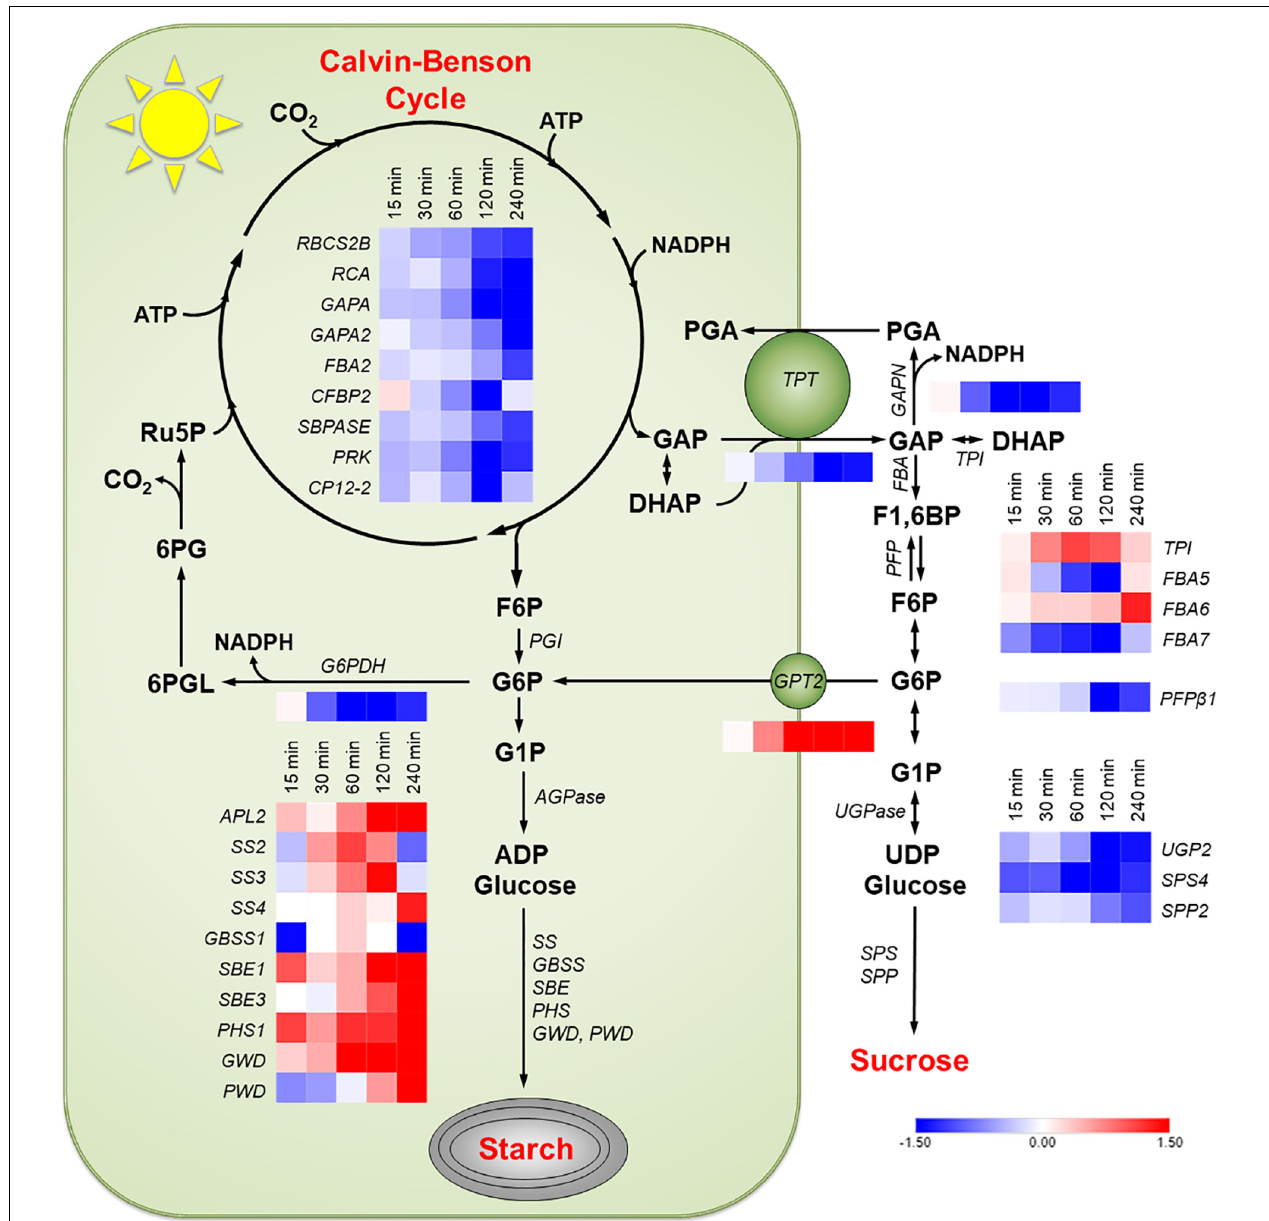
FIGURE 4 | Changes in transcription in Col-0 in response to an increase in PFD from 120 to 500 µ mol m − 2 s − 1 . Transcripts of the following pathways or genes are shown: Calvin-Benson cycle, starch synthesis, sucrose synthesis, the G6P shunt, the non-phosphorylating GAPDH ( GAPN ) in the cytosol, the glucose-6-phosphate transporter ( GPT2 ), and the triose phosphate transporter ( TPT ). Red boxes represent an increase in transcription and blue a decrease. Expression values shown had a log 2 RPKM fold change greater than one and are on an absolute scale of –1.5 to 1.5. n = 3.